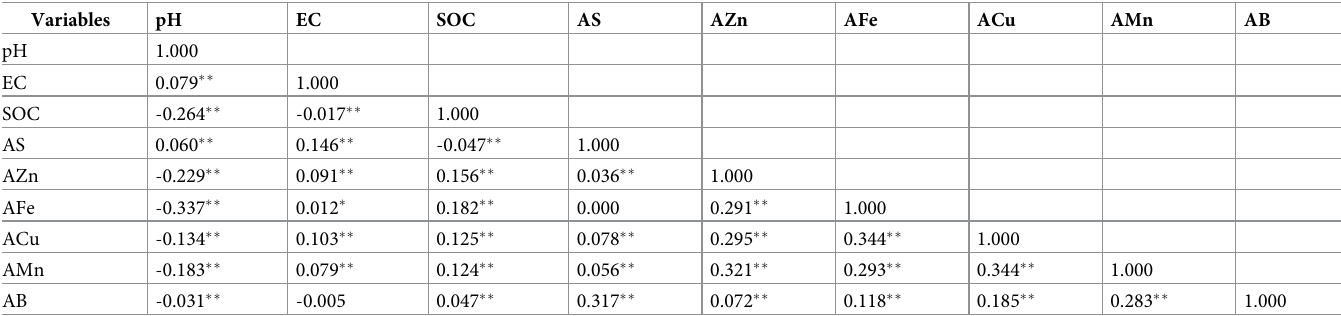
Table 3. Relationships among the soil parameters of cultivated areas of coastal India.